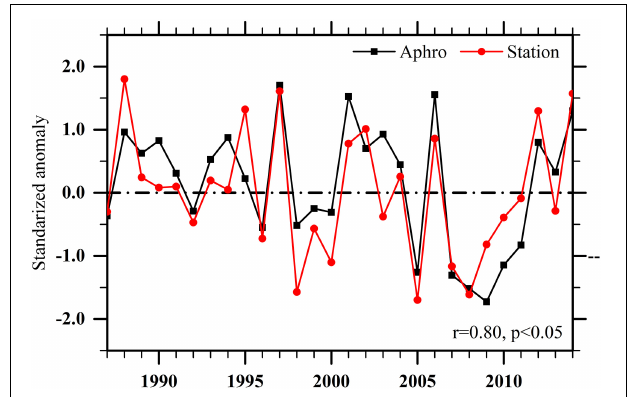
FIGURE 2 | Validation of APHRODITE (Aphro) data with 80 meteorological station data using correlation analysis between 1987 and 2015.